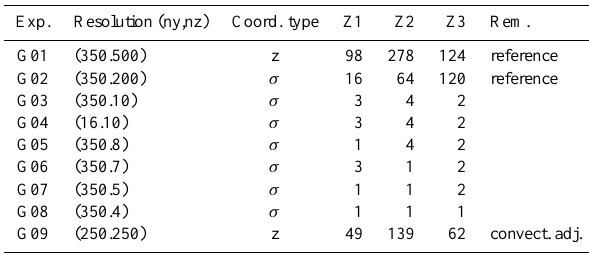
Table 1. List of the 2.5-D exps. The domain spans 50km in the y- direction. The number of levels in the vertical zones Z1, Z2 and Z3 (as explained in the text) are